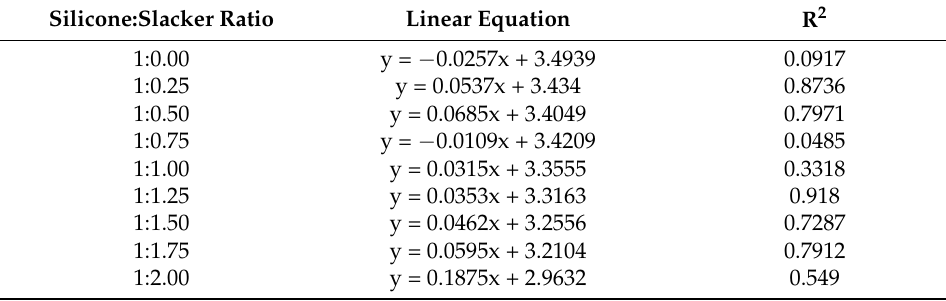
Table A2. Equations and R 2 values for individual trendlines in Figure 1b.